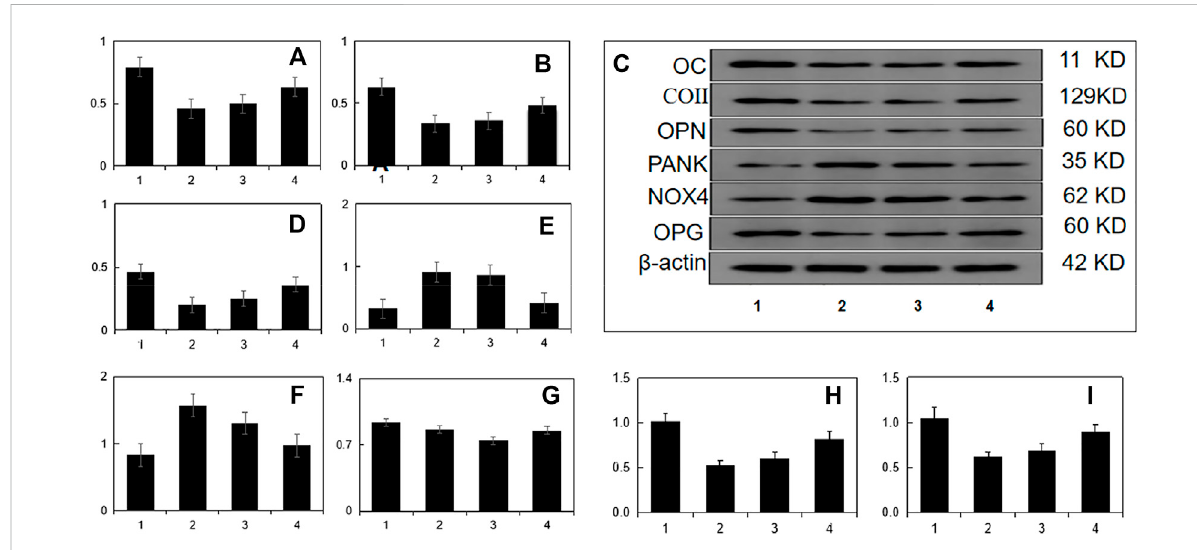
FIGURE 4 Continuous static pressure damage model index WB detection. Note:1:Blank control group 2:Model group3:Blank serum group 4:Drug containing serum group. (A) :OC/ β -actin, (B) :Co Ⅱ / β -actin, (D) :OPN/ β -actin, (E) :Rankl/ β -actin, (F) :Nox4/ β -actin, (G) :OPG/ β -actin; (H) :RT-QPCR was